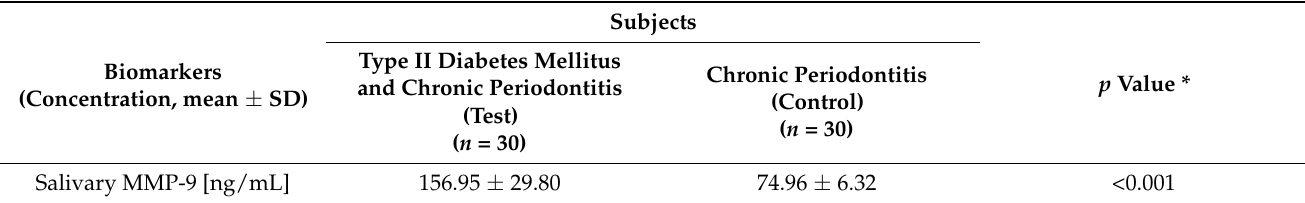
Table 3. Comparison of the levels of MMP-9 in salivary